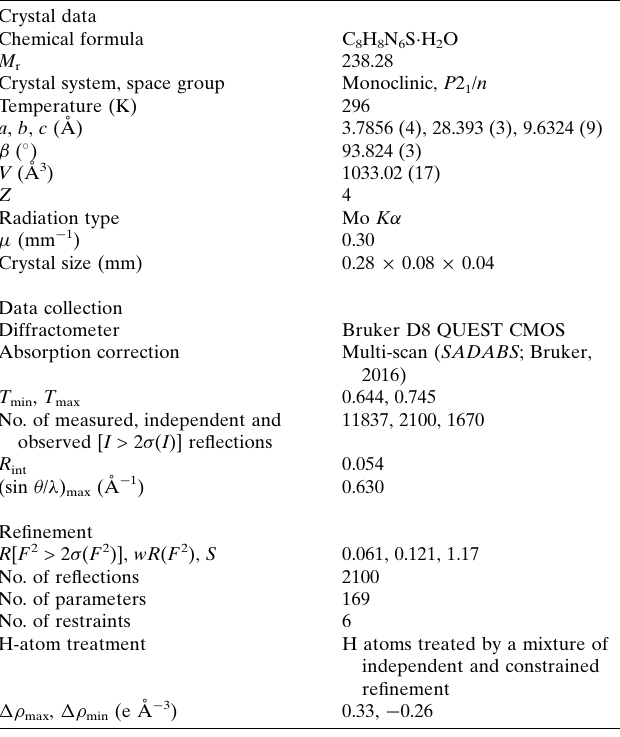
Table 2 Experimental details. Crystal data Chemical